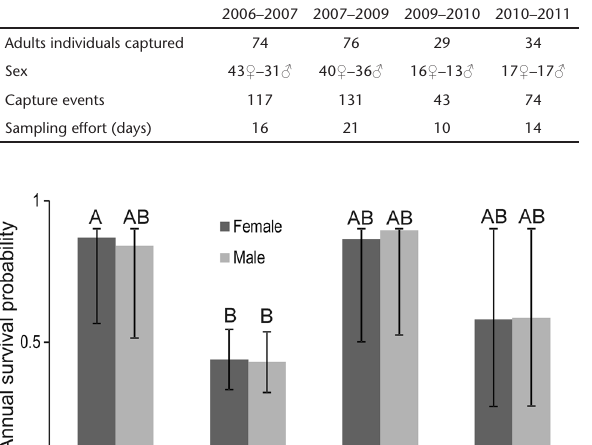
Table 1. Descriptive summary of annual field surveys for Chaeto- phractus vellerosus in Magdalena, Buenos Aires Province, Argentina.